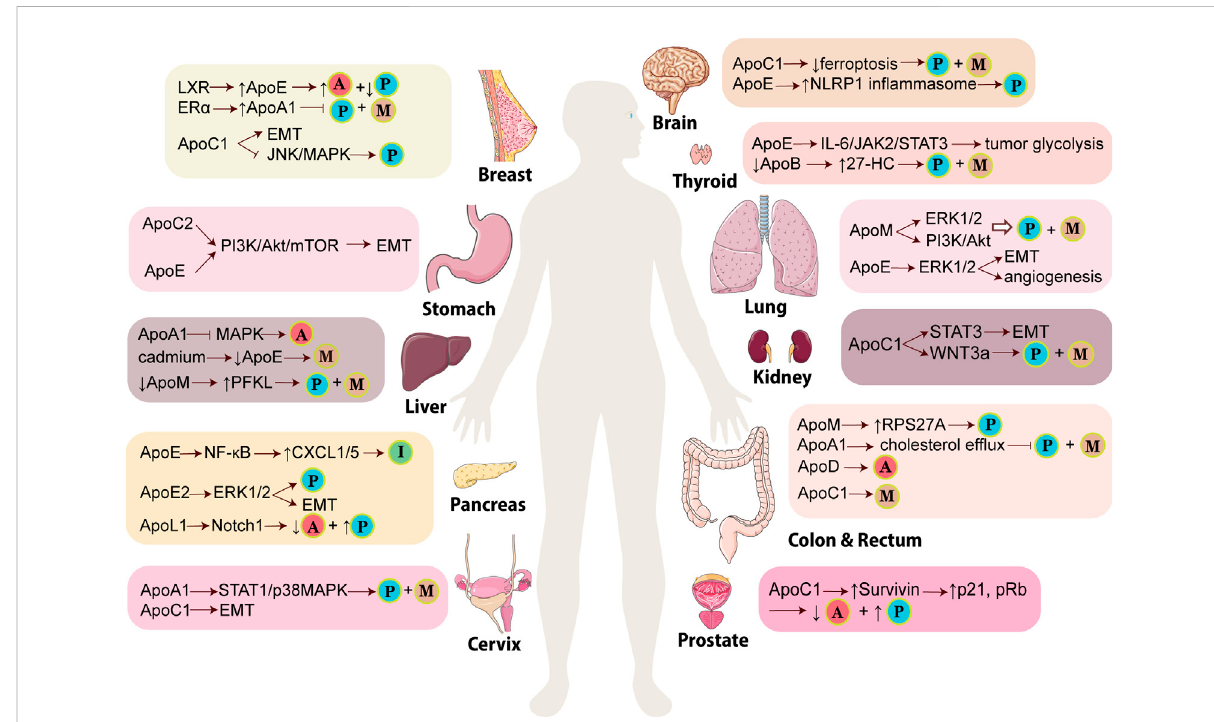
FIGURE 1 Mechanisms of APOs participating in the development of various cancers. In different types of cancers, APOs promote or inhibit tumor via differentsignalingpathwaysandleadtovariousresultsoftumors.ThelittleballsindicatethecriticaleventsofcancersinducedorpreventedbyAPOs. The ball with “ P ” means tumor proliferation while the ball with “ M ” means tumor metastasis, migration or invasion. The ball with “ A ” means tumor apoptosis whereas the ball with “ I ” means immune suppression. (LXR: liver X receptor; ER α : estrogen receptor α ; PFKL: ATP-dependent 6- phosphofructokinase, liver type; CXCL: C-X-C motif chemokine ligand; EMT: epithelial-mesenchymal transition; NLRP1 in fl ammasome: Nod-like receptor protein one in fl ammasome; 27-HC: 27-hydroxycholesterol; RPS27A: ribosomal protein S27A). This fi gure is partially made using Servier Medical Art